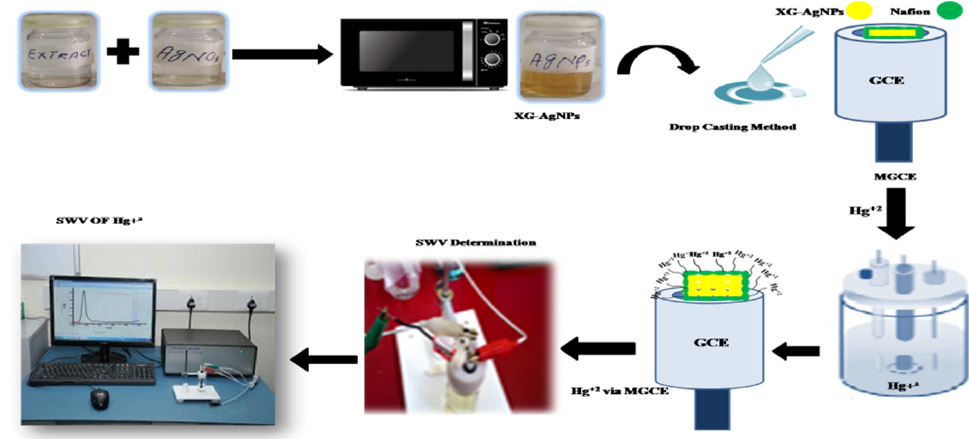
Figure 1. The scheme of construction of the sensor, regarding the stages of